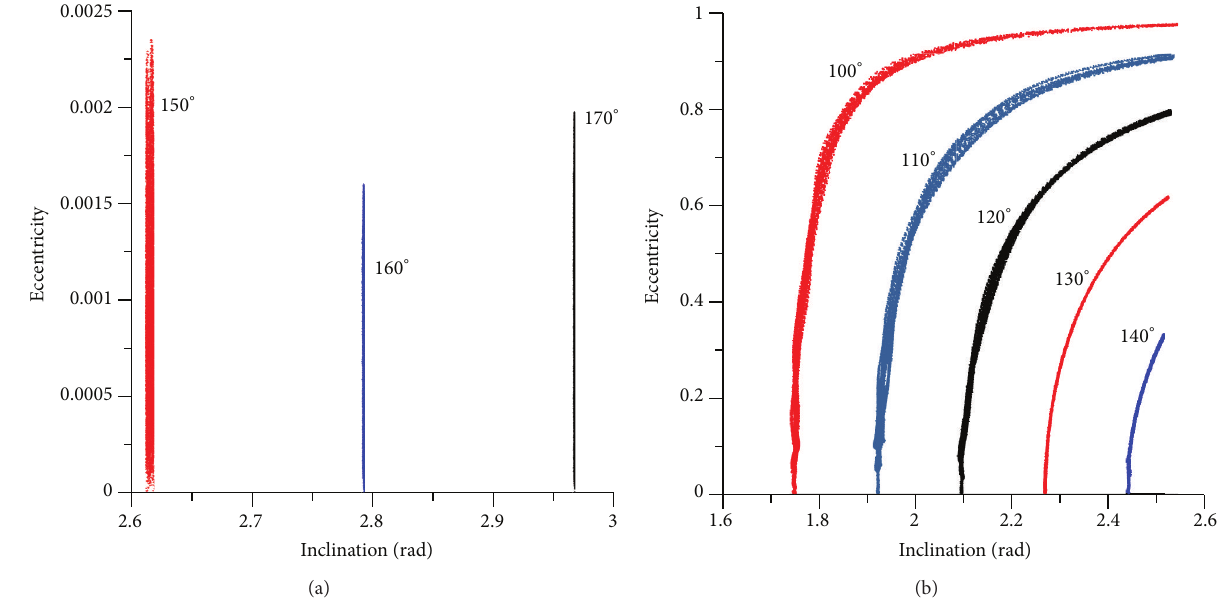
Figure 11: Plot inclination versus eccentricity for circular and retrograde orbits (exact model). The initial conditions are a = 0.341 canonical units, e (0) = 0, M 0 (0) = 0, 𝜔 (0) = 0, and Ω (0) =